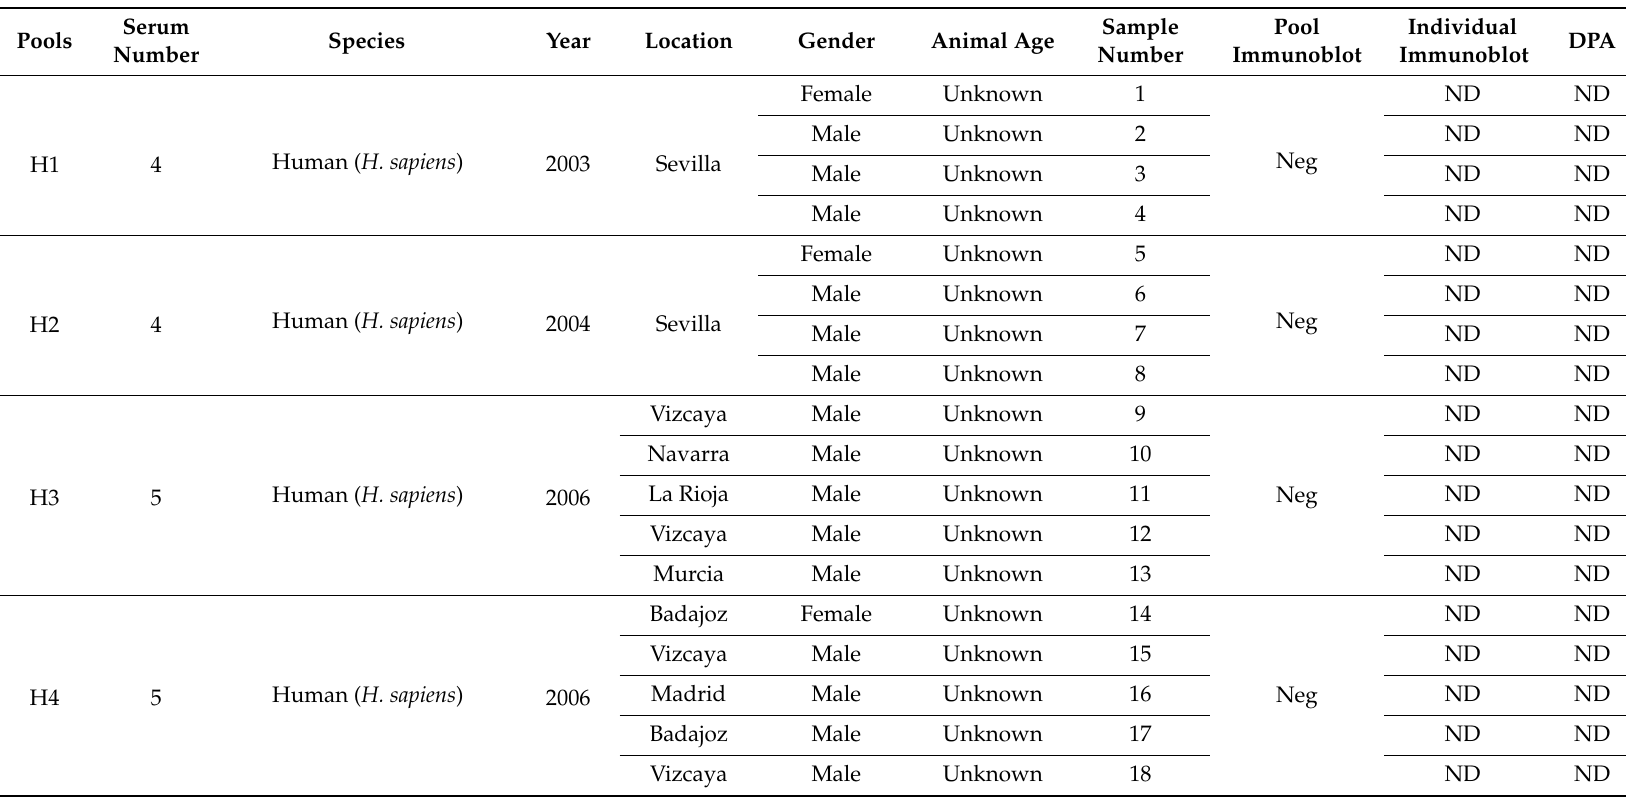
Table 1. Description of all sera used in the study. Samples are described according to the pool there were grouped, region of collection, sex, age range, immunoblot and Domain Programmable Arrays (DPA) results. ND: Not